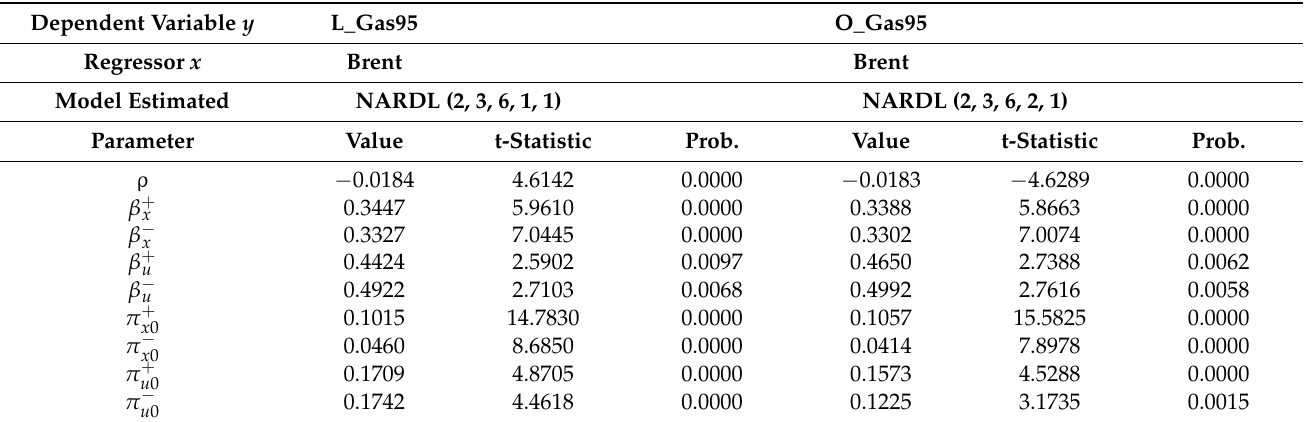
Table 6. NARDL estimation results—whole